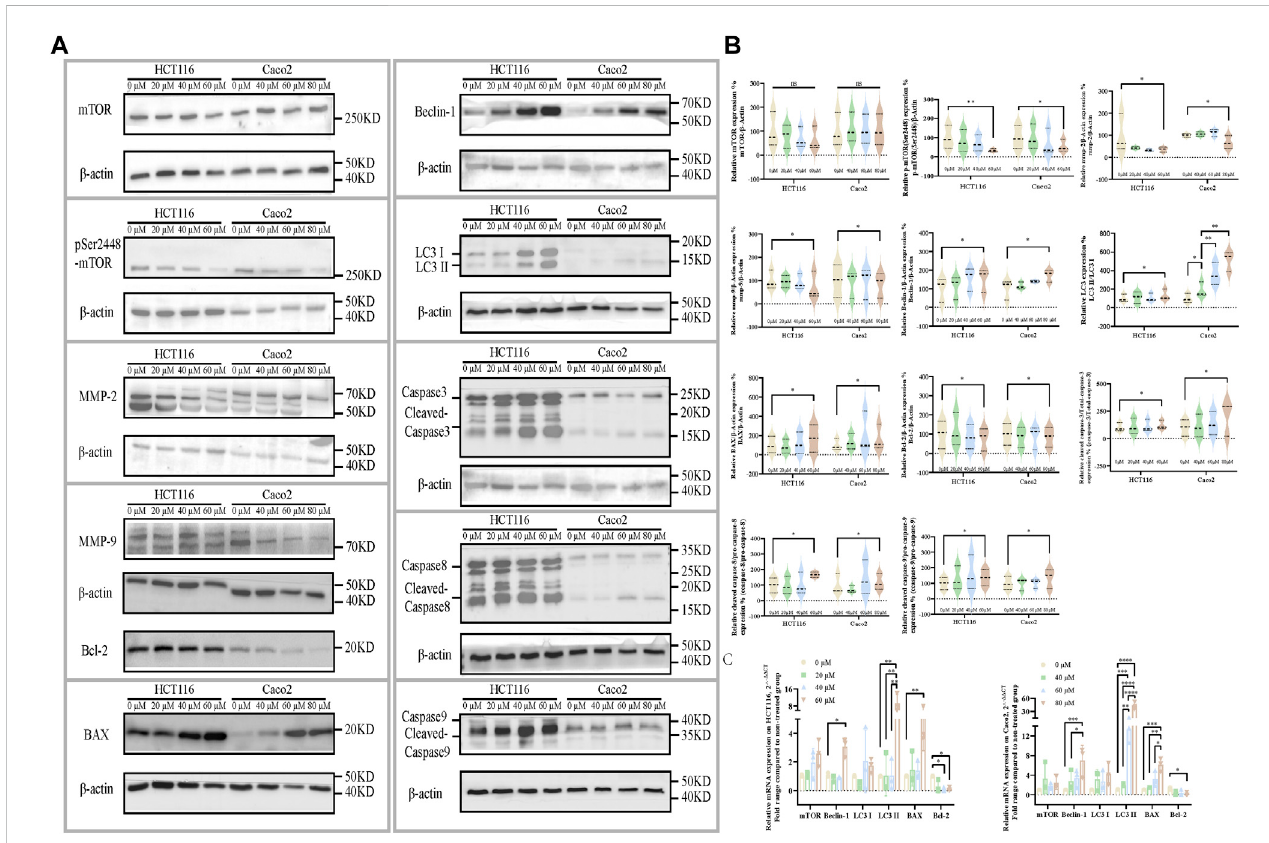
FIGURE 4 Ezetimibe downregulates the mTOR signaling, companied with a downstream invasion inhibition, apoptosis and autophagy activation. (A) Protein expressionofmTOR,mTOR pSer1448 ,MMP-2,MMP-9,BAX,Bcl-2,Beclin-1,LC3,caspase-3,caspase-8,caspase-9and β -actininHCT116andCaco2cellsunder gradient ezetimibe treatment. (B) Statistical analysis for the protein expression level of mTOR/ β -actin, mTOR pSer1448 / β -actin, MMP-2/ β -actin, MMP-9/ β -actin, Beclin-1/ β -actin, LC3 II/LC3 I, BAX/ β -actin, Bcl-2/ β -actin, cleaved caspase-3/total caspase-3, cleaved caspase-8/pro-caspase-8 and cleaved caspase- 9/pro-caspase-9 in HCT116 and Caco2 cells under gradient ezetimibe treatment. (C) Statistical analysis for the relative mRNA expression of mTOR, Beclin-1, LC3 I, LC3 II, BAX and Bcl-2 of gradient ezetimibe treated HCT116 and Caco2 cells. * p < 0.05, ** p < 0.01, *** p < 0.001, **** p <